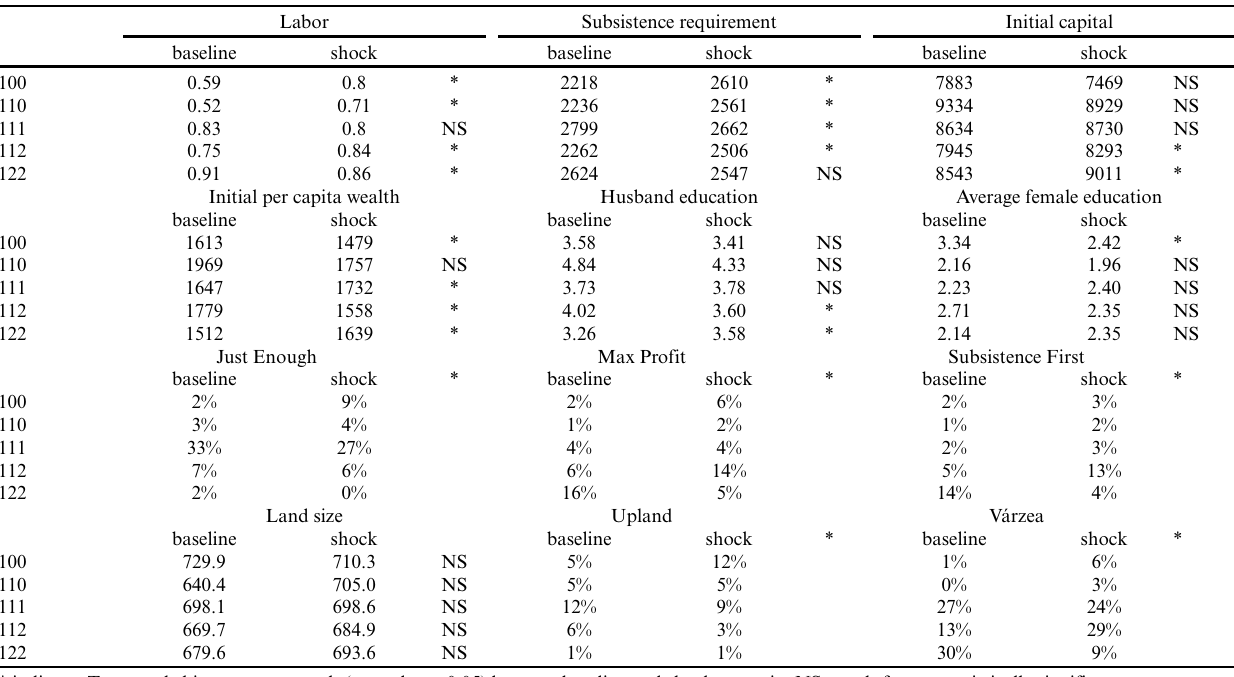
Table 5 . Initial household characteristics among different trajectories of chronic poor